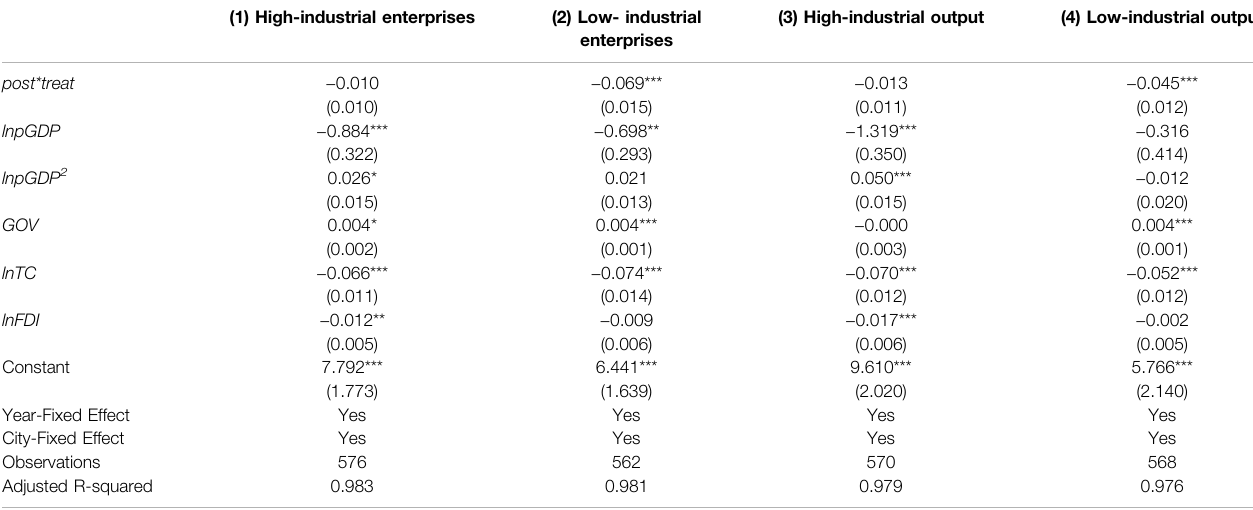
TABLE 5 | Heterogeneity effects of the number of industrial enterprises and total industrial output.